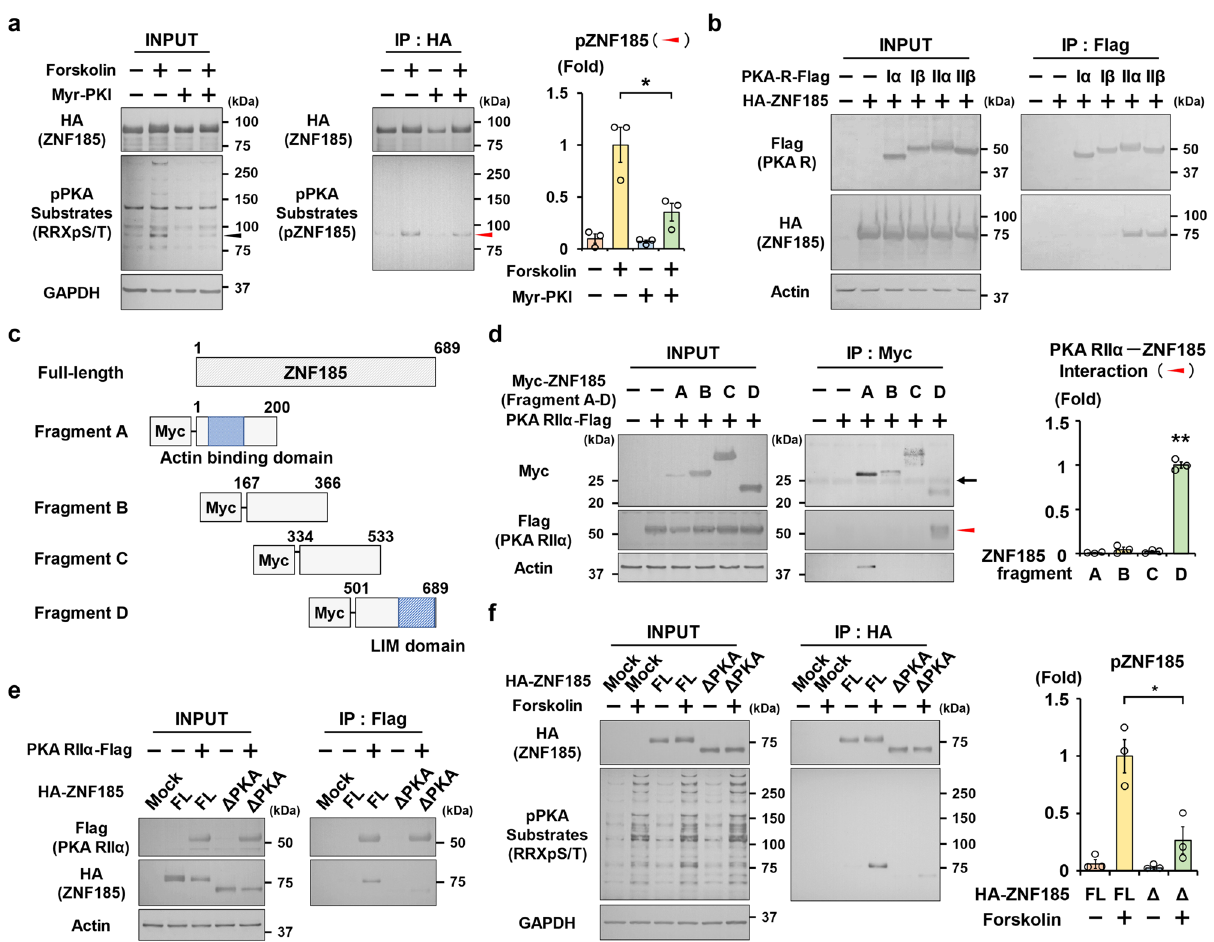
Fig. 2 The ZNF185 – PKA interaction is responsible for ZNF185 phosphorylation. a Phosphorylation of ZNF185 is inhibited via Myr-PKI. HUVECs overexpressing Myc-ZNF185-HA were pretreated with Myr-PKI for 1 h before forskolin stimulation for 1 h. Anti-HA-beads were used for immunoprecipitation. The arrowheads indicate phosphorylated ZNF185. Densitometric analysis of pZNF185. Two-sided Student ’ s t test, * p < 0.05 ( n =